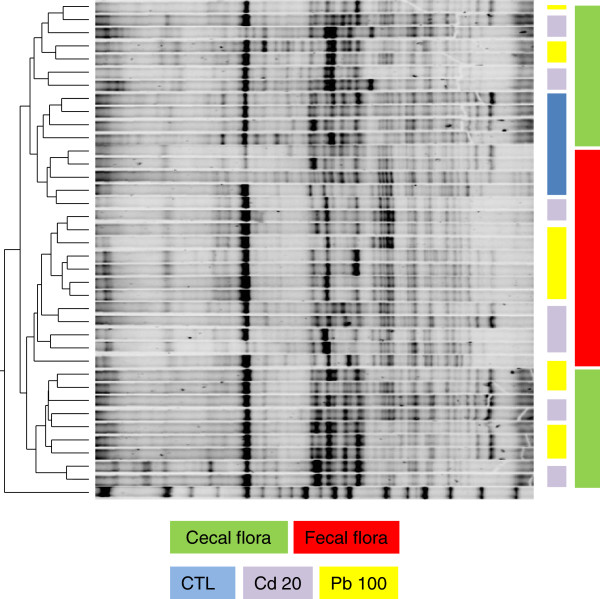
An unweighted pair group method with arithmetic mean tree of the same gels. Pairwise similarities were calculated with BioNumerics software (version 6.6.4), using a Dice coefficient with 0% optimization, 0.3664% fixed tolerance, exclusion of uncertain bands and no relaxed doublet matching, fuzzy logic or area sensitivity.